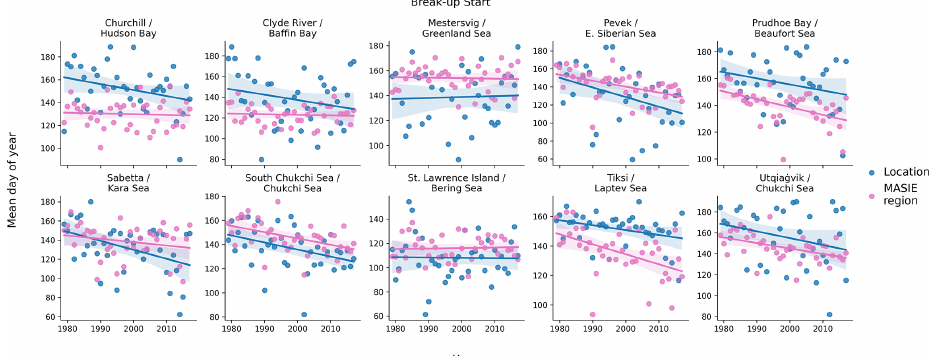
Figure 9. Yearly values (1979–2018) of the breakup start dates (shown as day-of-the-year numbers) for the coastal locations (blue) and the corresponding MASIE regions (pink). Date scales on the y axis vary among panels in order to optimize the display of data points. Linear regression lines are shown with the same color coding. In each panel, the upper line of header identifies the coastal location and the lower line identifies the MASIE region. All values are based on the modified J&E algorithms. Slopes and their significance levels are listed in Tables S2 and